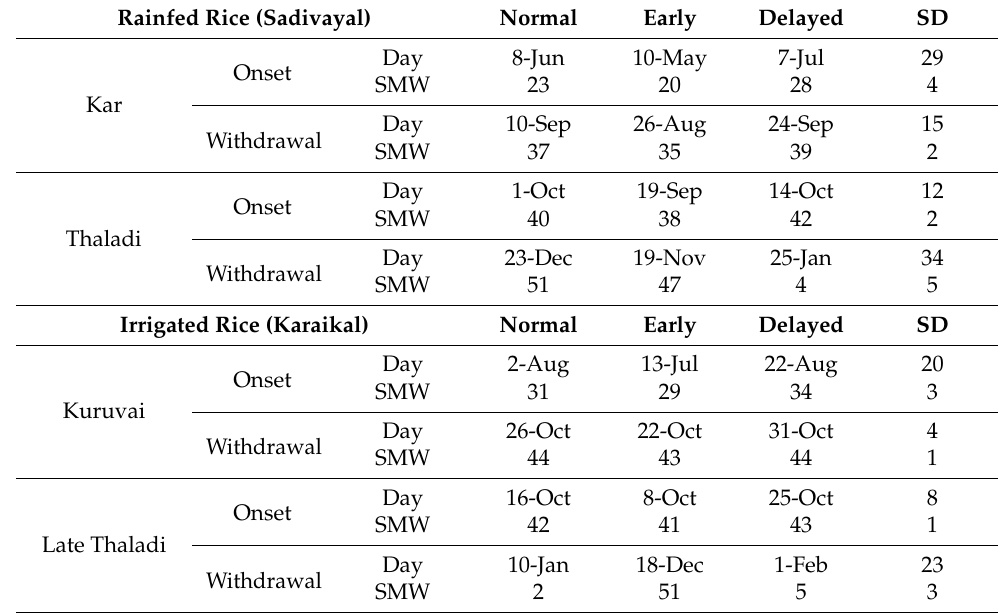
Table 3. Normal, early, and delayed onset and withdrawal of monsoon during major rice-growing seasons in Sadivayal and Karaikal. Rainfed Rice (Sadivayal) Normal